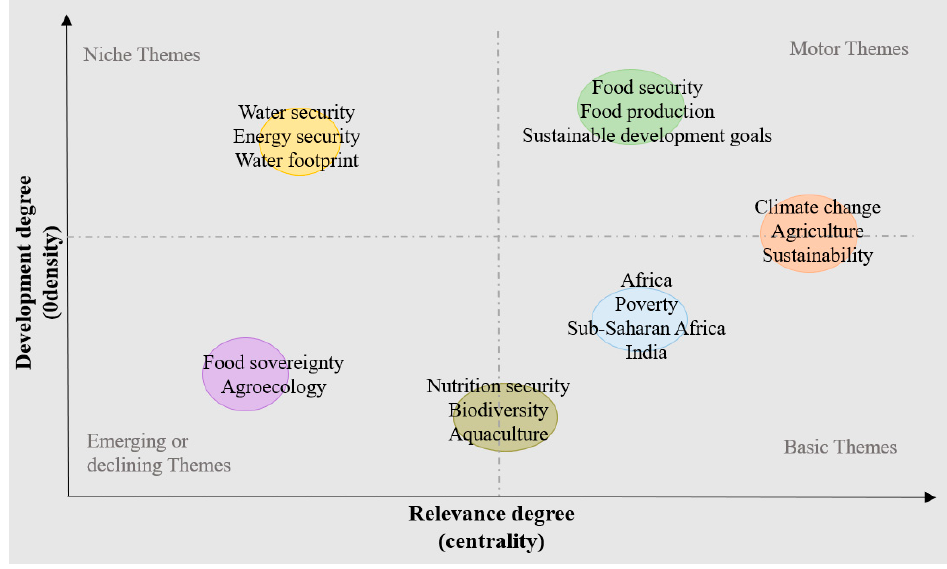
Figure 7. Distribution of themes in food security